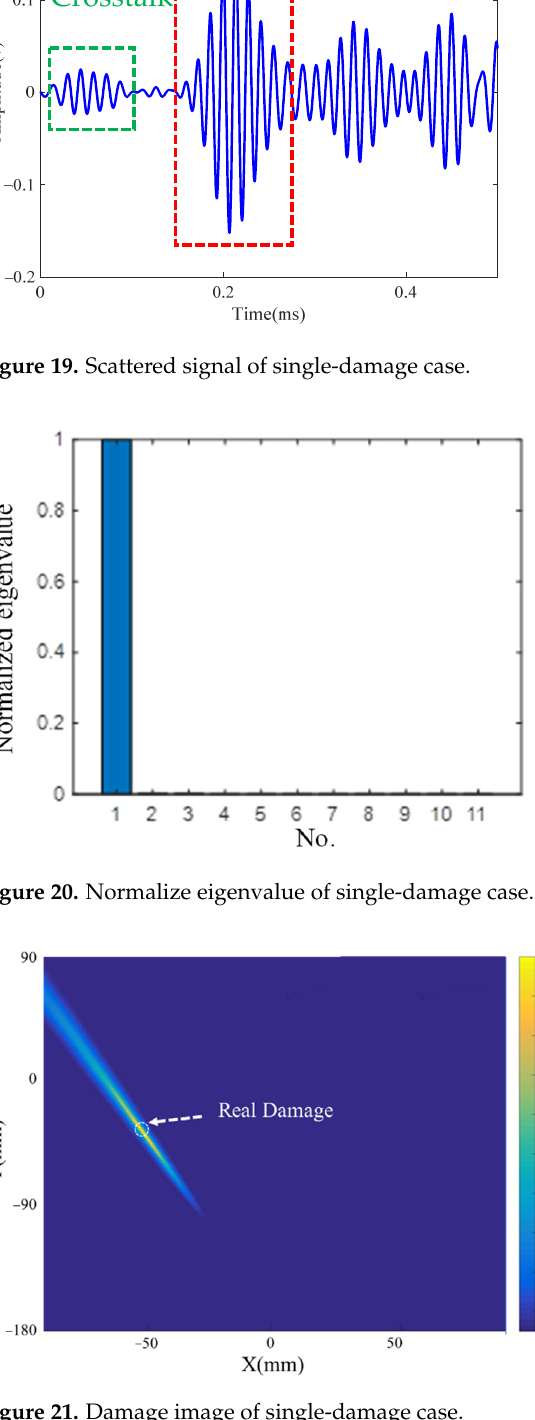
Figure 21. Damage image of single ‐ damage case.